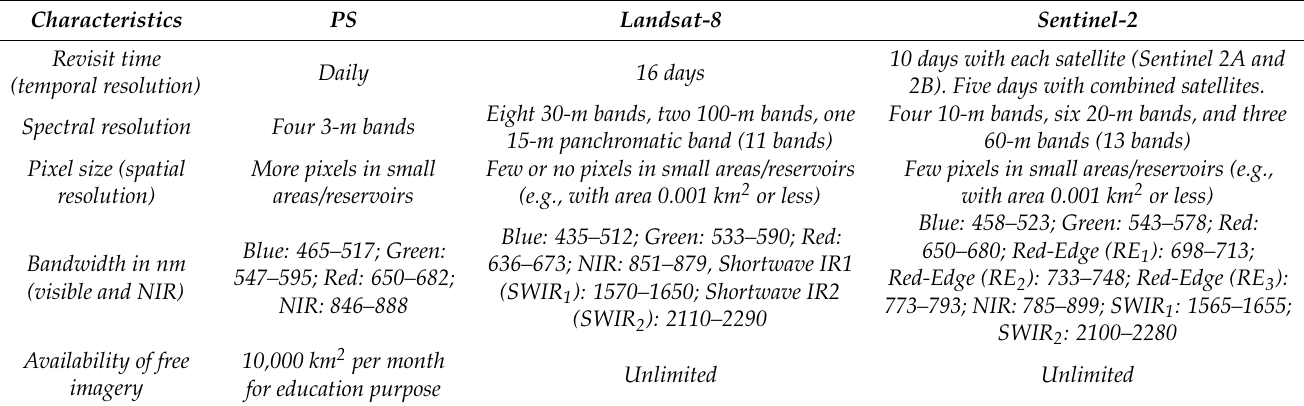
Table 1. Characteristics of Landsat-8, Sentinel-2, and